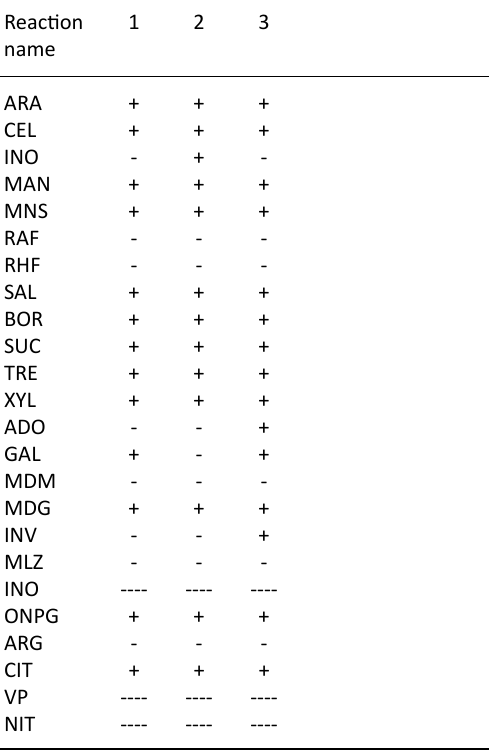
Table 2. Biochemical reactions of using the test of Microgen Biochemical ID Software Microgen GN-